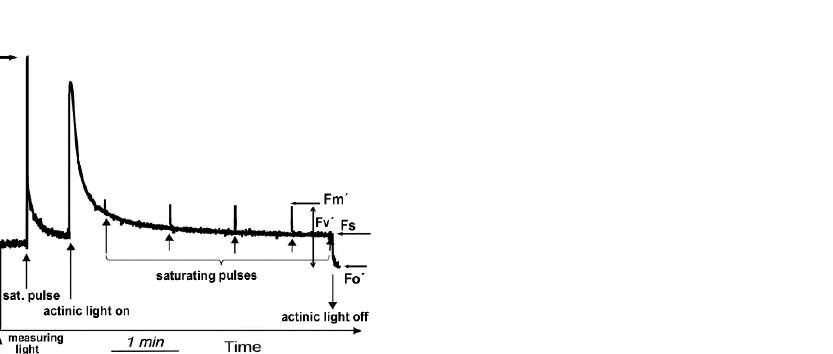
Figure 2. A typical modulated fluorescence trace using dark-adapted leaf material showing how F o , F m , F o ′ , F m ′ and F s , are formed to measure chlorophyll fluorescence parameters. In the dark-adapted state a “measuring light” of low light intensity is switched on to induce electron transport through PSII and to elicit the minimal level of chlorophyll fluorescence, termed F o . A brief saturating pulse of light results in the formation of the maximum yield of fluorescence, F m . The difference between F m and F o is the variable fluorescence, F m . The application of saturating pulses under actinic light illumination closes all the reaction centers and provides the maximum fluorescence in the light- adapted state, termed F m ′ . The steady-state level of fluorescence in the light is termed, F s and is measured immediately before switching off the actinic light. F o ′ is measured immediately after switching off the actinic light. The difference between F m ′ and F o ′ is the variable fluorescence, F v ′ (Adopted from [26]).